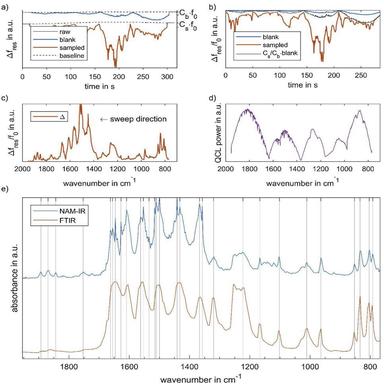
NAM-IR data analysis of blank and paracetamol coated resonator: a) raw data, b) scaled signal, c) subtraction of reference and sample signals, d) QCL spectrum and e) final NAM-IR results in direct comparison with FTIR spectra of paracetamol.